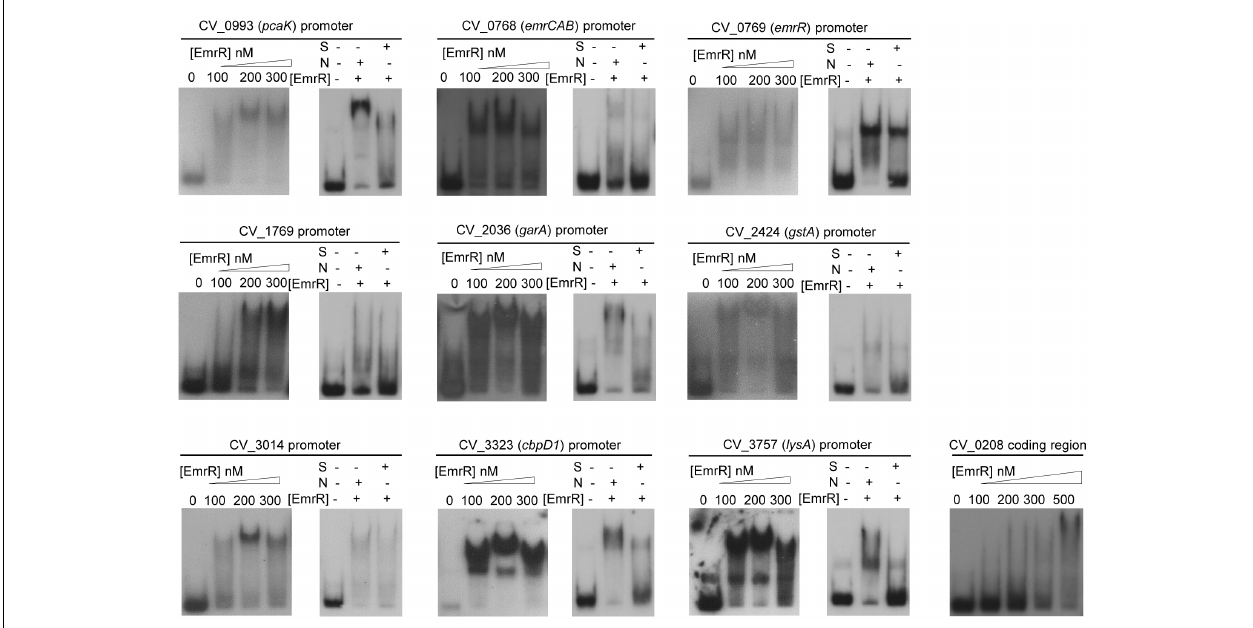
FIGURE 5 | EmrR acts as a direct transcription repressor. EMSA assays with labeled probes containing the promoter regions of the indicated EmrR target genes, incubated with different concentrations of purified EmrR protein (100, 200, and 300 nM EmrR). For all cases, competition assays were performed (right panels) using 200 nM EmrR in the presence of 30-fold excess of unlabeled fragments of the same region (S) or the coding region of CV_0208 (N) as competitors. Differences in some competition assays suggest that EmrR has distinct affinities for its binding sites. A control assay performed with the coding region of CV_0208 indicated that at 500 nM, EmrR bound in a nonspecific manner.